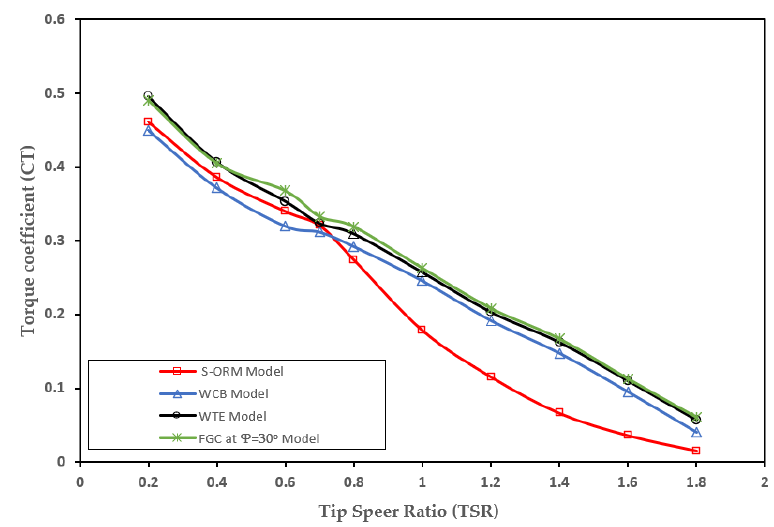
Figure 17. Results of the simulation of the variations in the torque coefficients of modified models, along with the S-ORM.